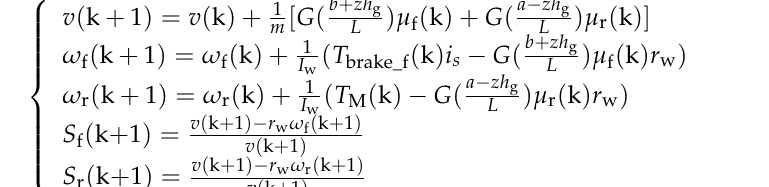
Figure 10. Model prediction algorithm flow.